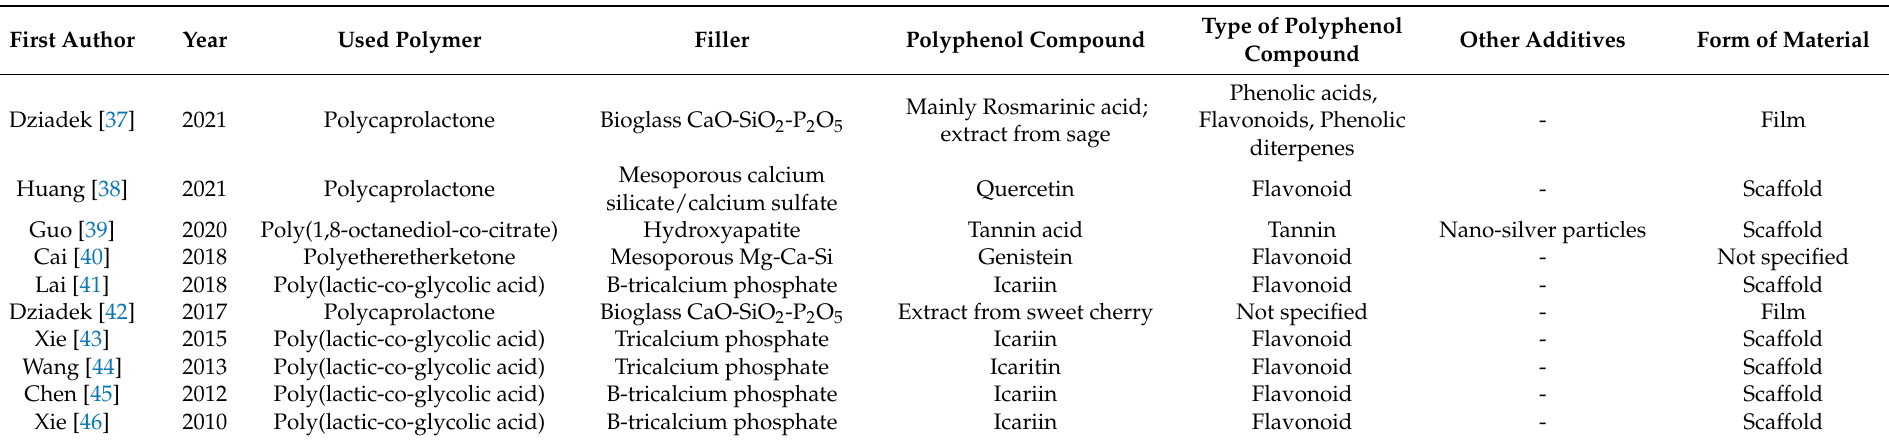
Table 3. List of reports on composites based on synthetic